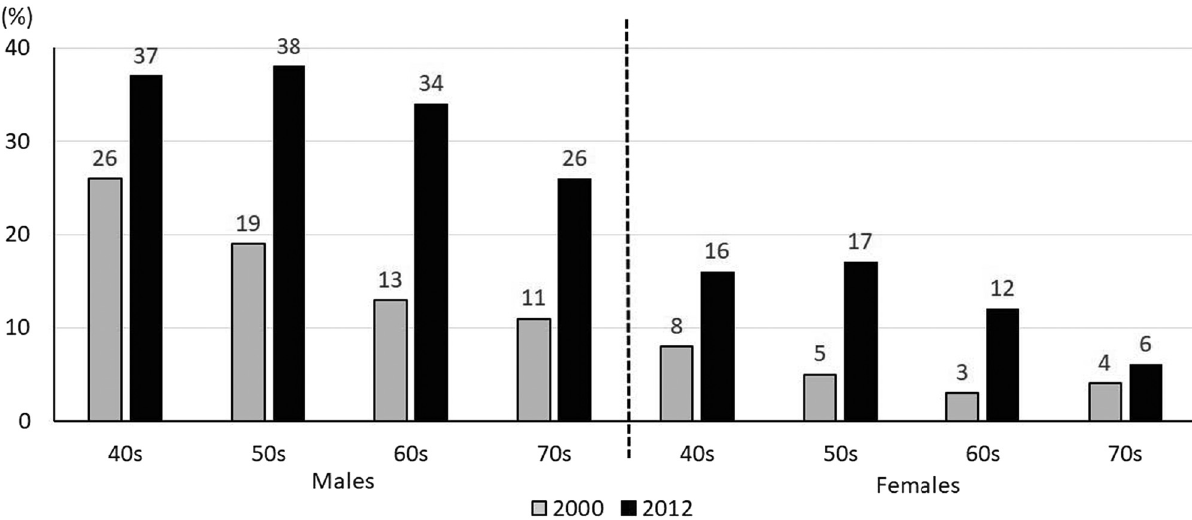
Figure 4: The ratio of people who responded “ having intimate relationship with a friend/lover of the opposite sex, other than the spouse, does not matter unless such relationship do any harm the relationship with the spouse ” across age groups in percentage [ 28 ]